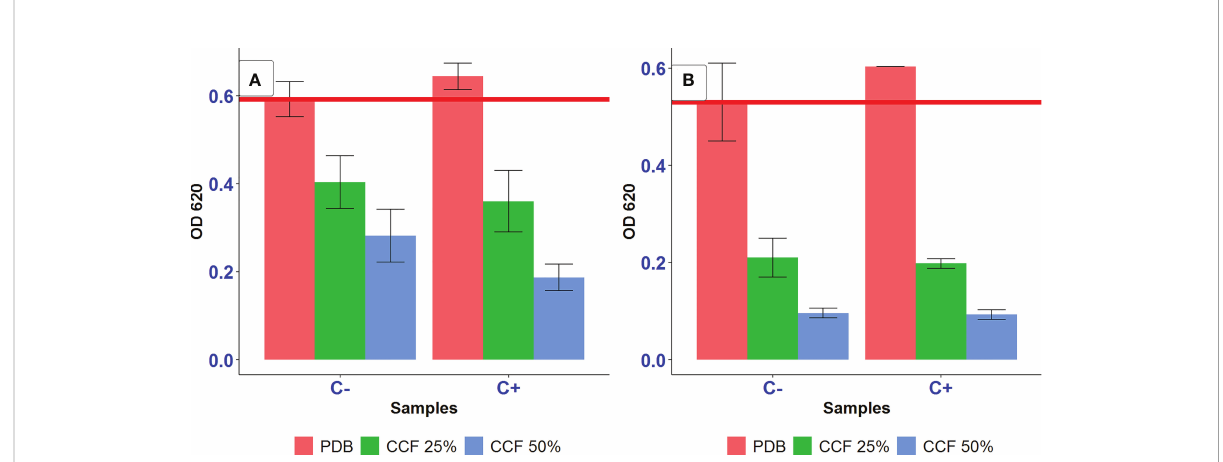
FIGURE 5 The effect of 25 and 50% CCF of P. resinovorans SZMC 25872 obtained from LMM amended with succinic acid (A) and L-alanine (B) on the growth of A. tumefaciens SZMC 14557 in the absence (C-) and presence (C+) of 0.17 mg/ml ascorbic acid. PDB is positive control (no added CCF), CCF 25% and CCF 50% are the corresponding CCF concentrations. The red line represents the lowest value of the positive